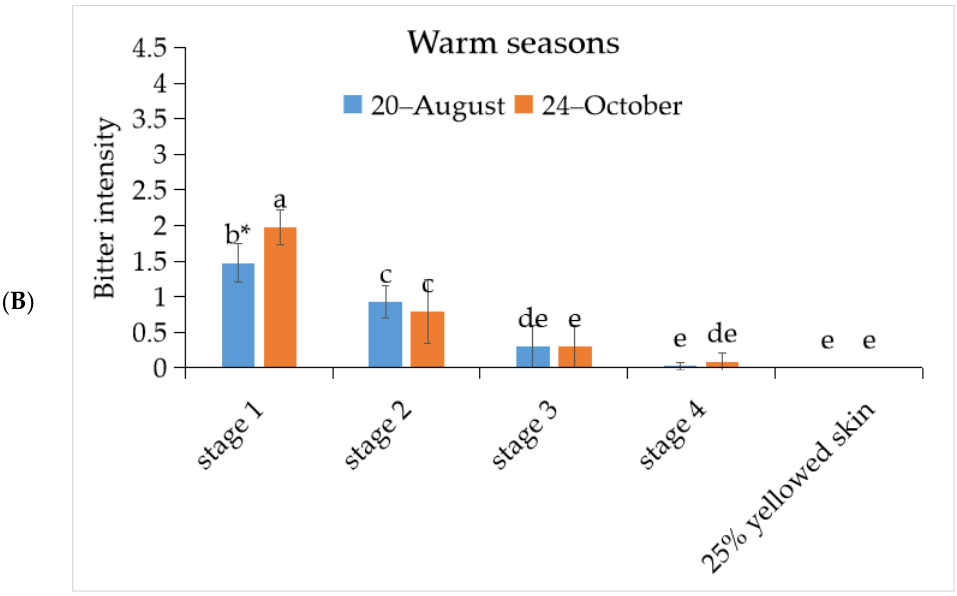
Figure 1. Bitterness intensity in different maturity of papaya fruit: ( A ) Cool season ( B ) Warm season. Data are mean ± SD, n = 4. * Mean statistical data within a column were obtained by Duncan’s test at the 5% level (same letters means no significance).